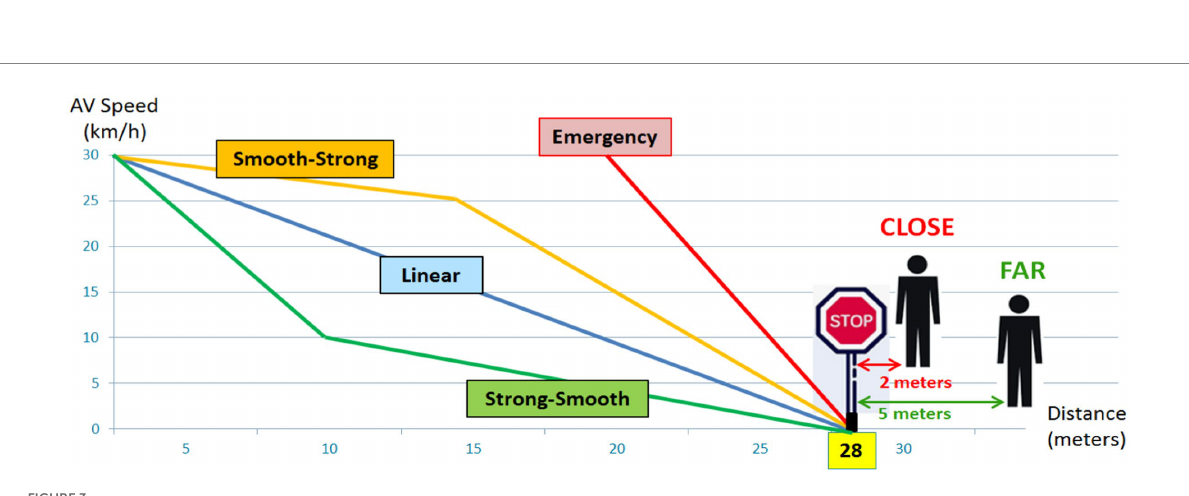
FIGURE 3 Braking behaviors to yield of the automated